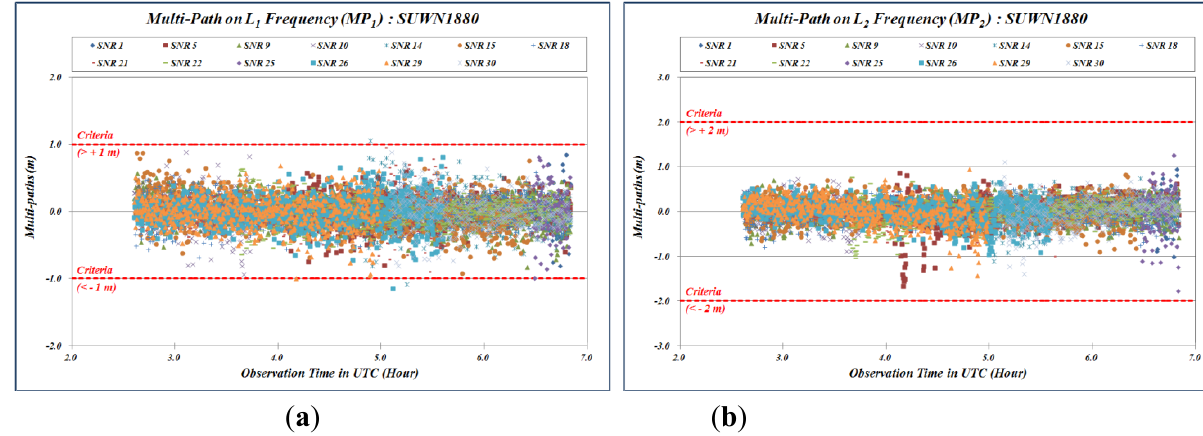
at each observation epoch. 2